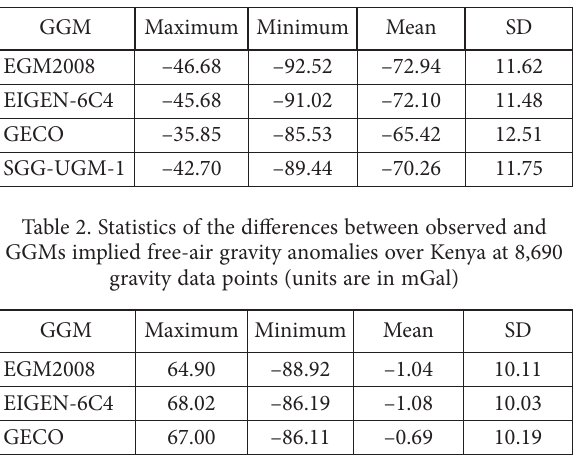
Table 1. Statistics of the differences between observed and GGMs implied geoid undulations over Nairobi area at 18 GPS/